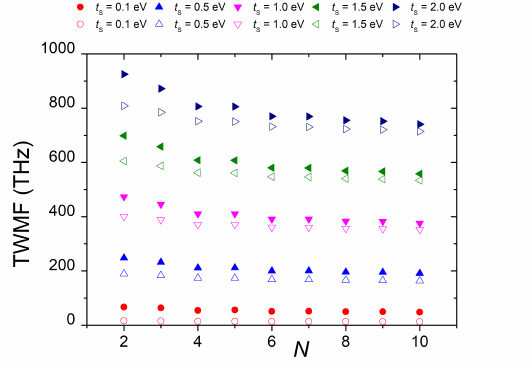
Figure 6. Dipole moment oscillations (in atomic units) for a G... homopolymer N = 10. Initial carrier placement at site α = 2 ( left ) and site α = 3 ( right ). Top row: t S = 0.1 eV. Bottom row: t S = 1 eV.